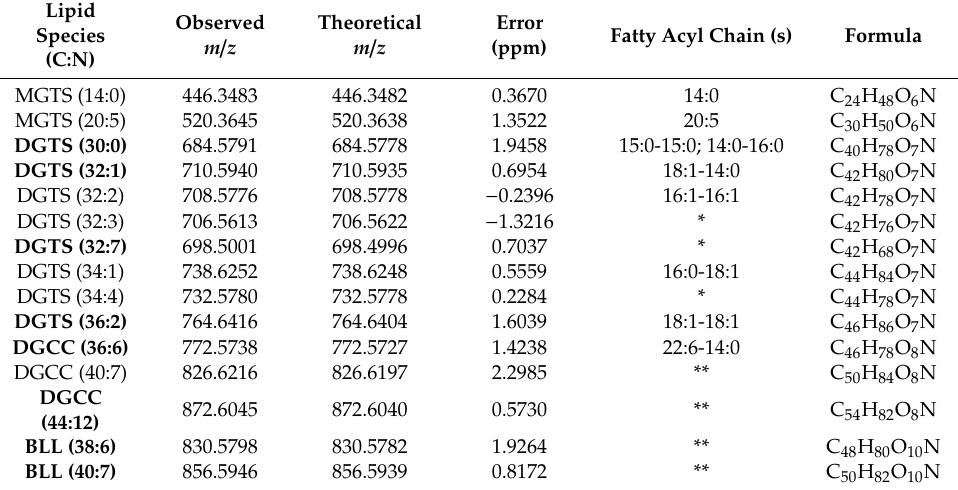
Table 4. Betaine lipid species identified by liquid chromatography–mass spectrometry (LC–MS) in positive mode as [M + H] + ions (error < 5 ppm). The identification as betaine lipids and fatty acyl composition of DGTS and MGTS was confirmed by analysis of tandem MS (LC–MS / MS) spectra of [M + H] + ions. The fatty acyl composition of DGCC was determined by LC–MS / MS spectra of [M + CH 3 COO] – ions. The numbers in parentheses (C:N) indicate the number of carbon atoms (C) and double bonds (N) in fatty acyl chains. The most abundant species of each class (relative abundance > 10%) are indicated in bold. Species identified only by retention time and mass accuracy are marked with an asterisk (*). Species identified by retention time, mass accuracy, and confirmation of polar head by positive LC–MS / MS are marked with two asterisks (**). MGTS, monoacylglyceryl-N,N,N-trimethyl-homoserine; DGTS,